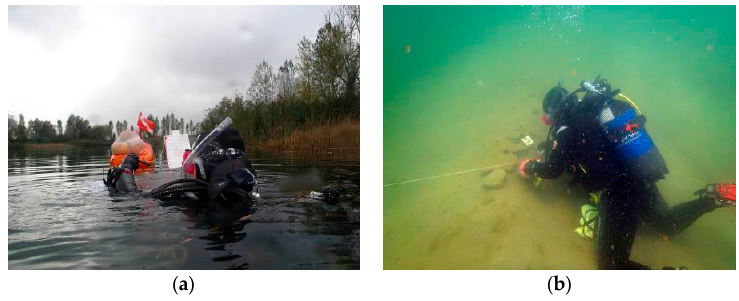
Figure 11. Photographs of the underwater survey operation in Lago Tramonto, Gambulaga, Portomaggiore (FE, Italy): ( a ) Setting of the equipment before the survey; ( b ) Pegging the underwater topographical reference point (photo by Antonio Duccoli and Paolo Farina).